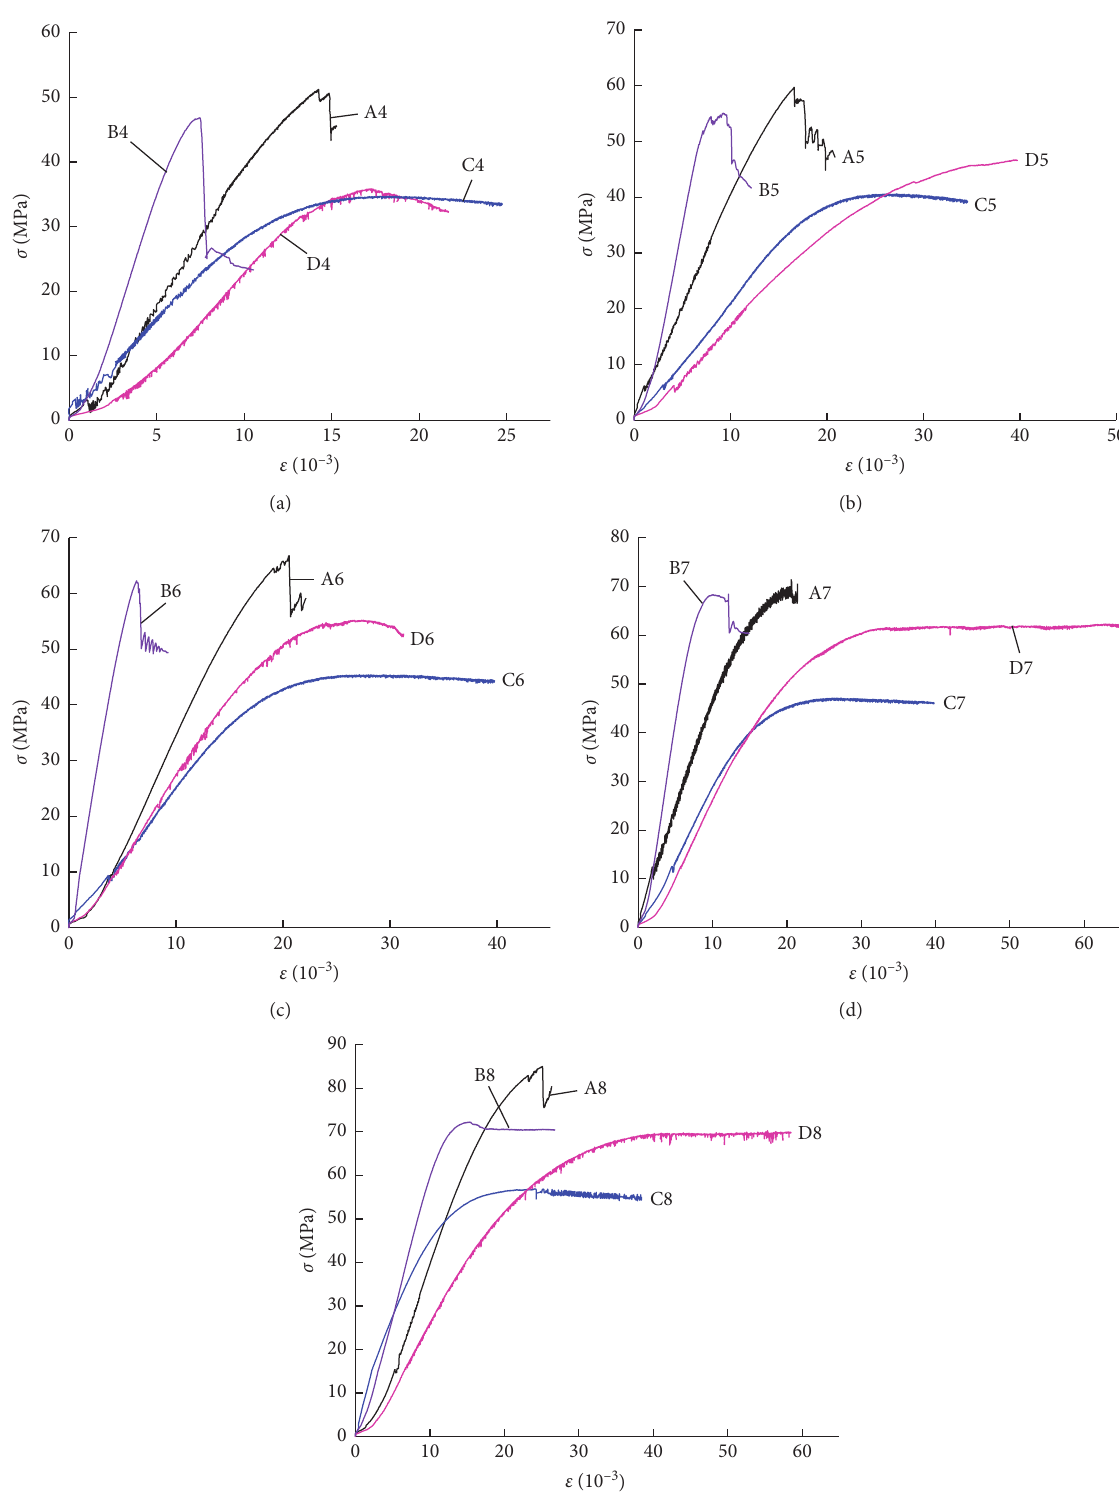
Figure 10: Stress-strain curves of the specimens under the same confining pressure and different water content conditions. . (a) σ (b) σ 3 � 6 MPa. (c) σ 3 � 9MPa. (d) σ 3 � 12MPa. (e) σ 3 �